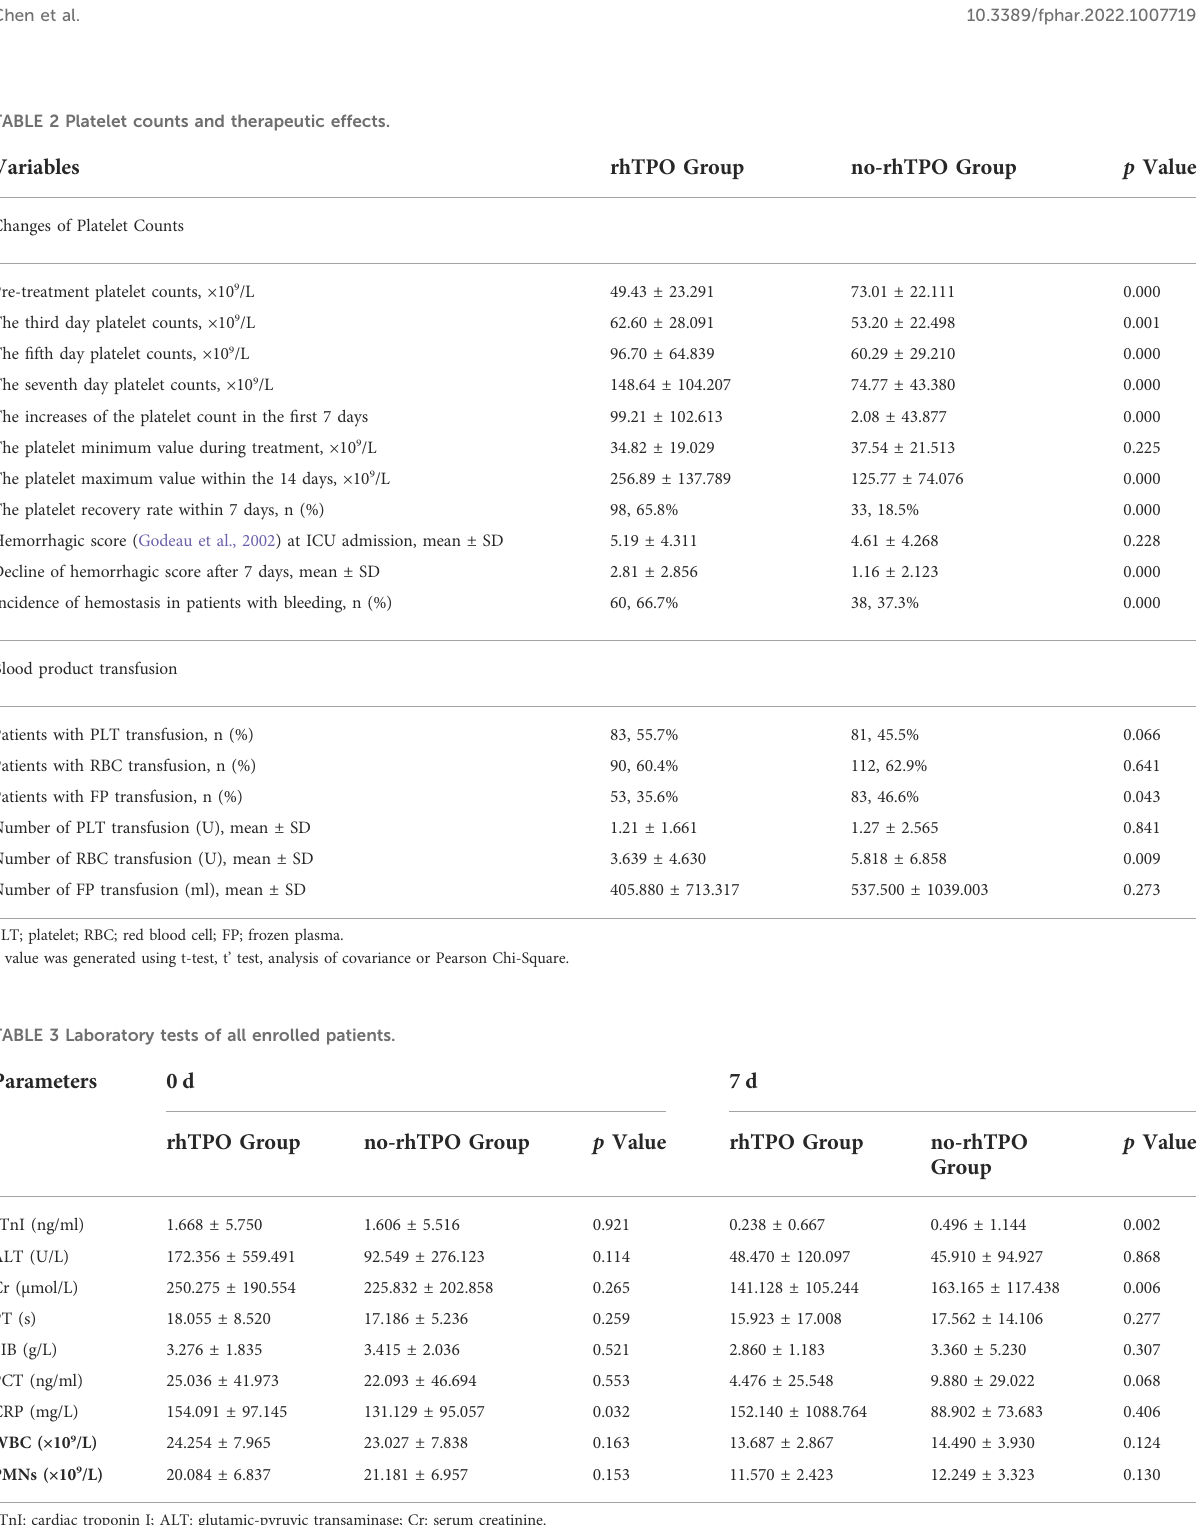
(60 of 90) of the rhTPO treatment group, compared with 37.3% (38 of 102) in the no-rhTPO group on the 7th day ( p = 0.000, Table 2).